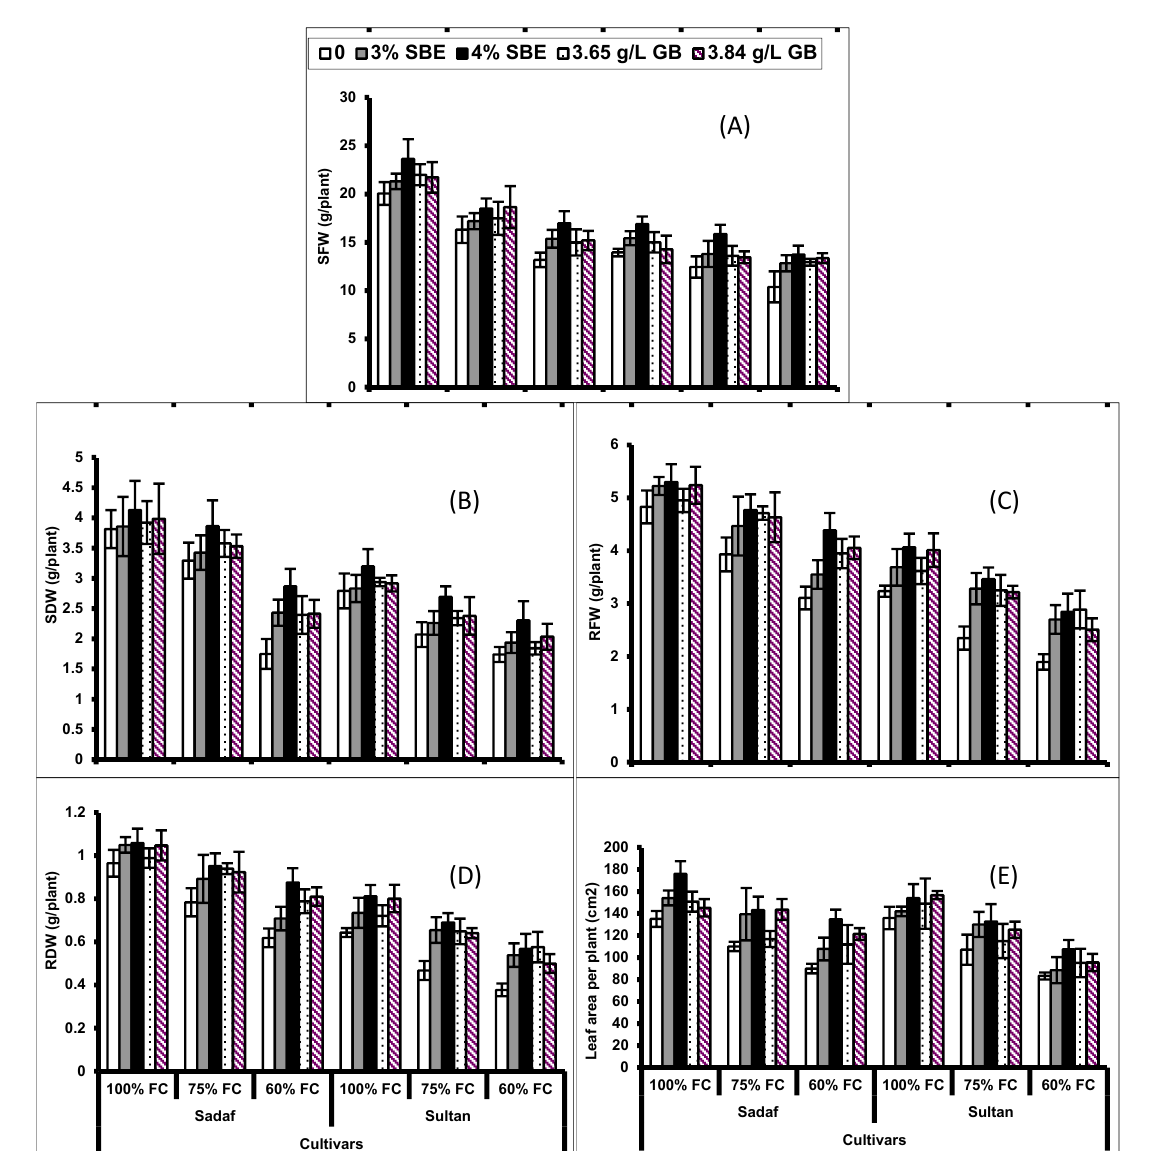
Figure 1. ( A ) Shoot fresh weight (SFW), ( B ) shoot dry weight (SDW), ( C ) root fresh weight (RFW), ( D ) root dry weight (RDW) and ( E ) leaf area of two maize cultivars foliar-fed with different levels of sugar beet extract (SBE) and glycine betaine under water deficit conditions (Mean ± S.E.). Table 1. Analyses of variance data for growth attributes of maize cultivars subjected to varying levels of sugar beet extract (SBE) and glycine betaine under water deficit conditions.